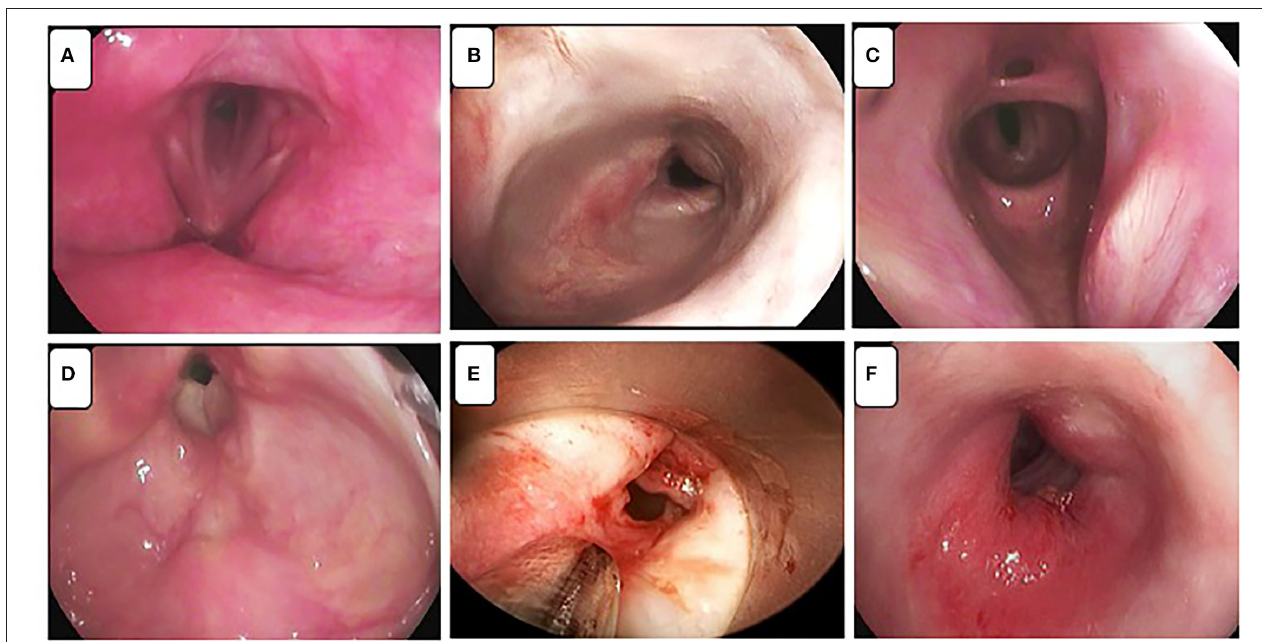
FIGURE 1 | Different patterns of laryngotracheal stenosis (LTS) associated with endotracheal intubation or tracheostomy placement. (A) Patient 1: cicatricial subglottic stenosis due to long-term intubation. (B) Patient 2: tracheal stenosis resulting from tracheostomy cuff injury. (C) Patient 3: same condition at different levels of the airway with a complex diaphragm stenosis. (D) Patient 4: inflammatory subglottic stenosis with granulomatous’ tissue. (E) Patient 6: subglottic stenosis after dilatations. (F) Patient 8: subglottic stenosis with oedema and inflammatory aspect of vocal